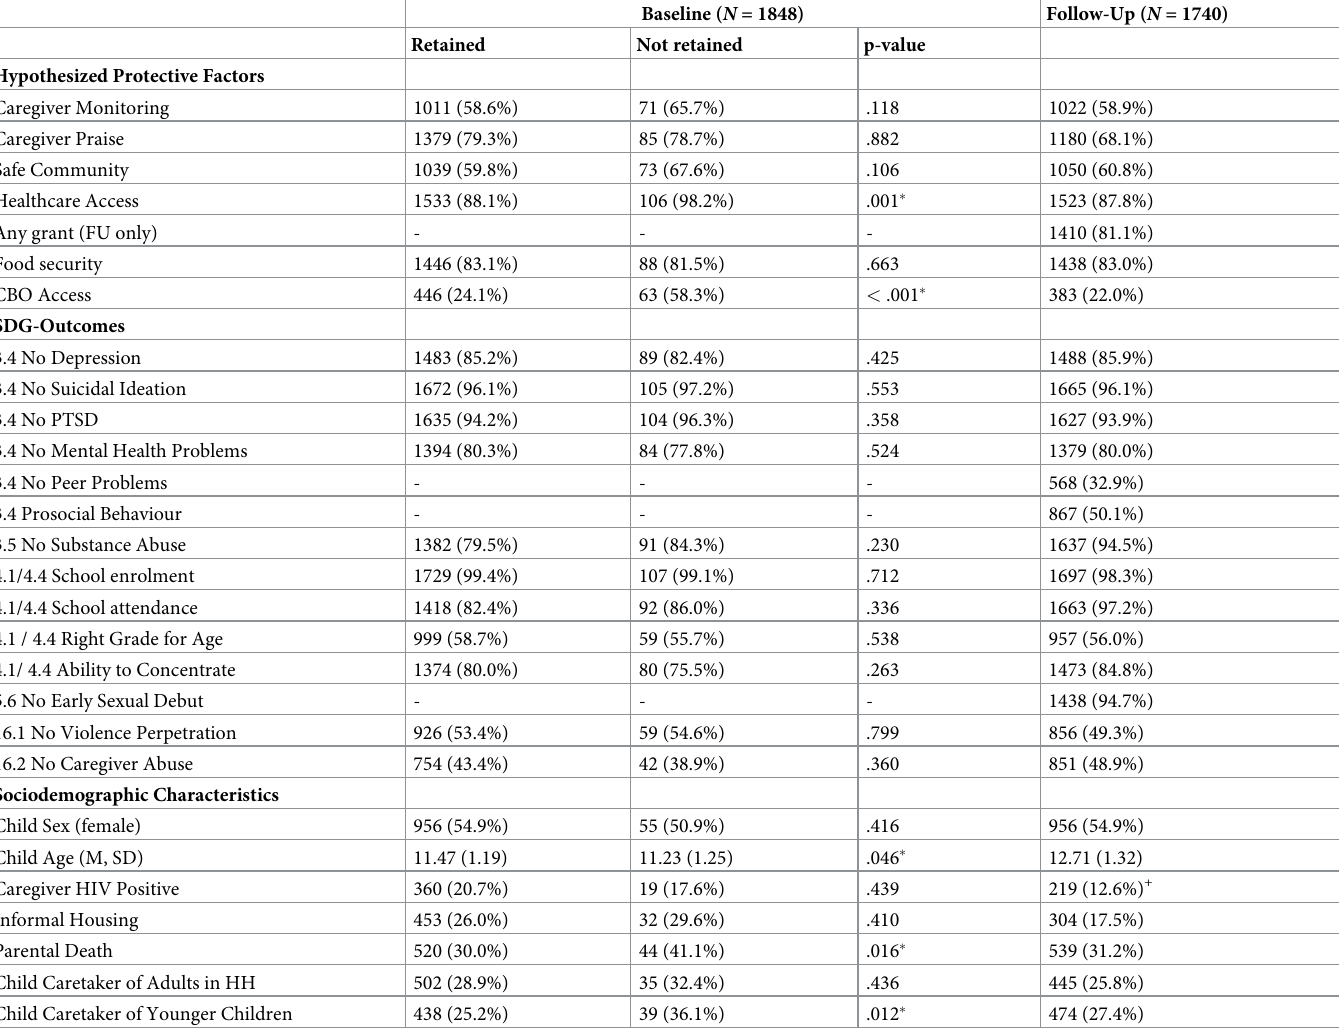
Table 1. Access rates to the hypothesized protective factors, SDG-related outcomes and socio-demographic covariates across baseline and